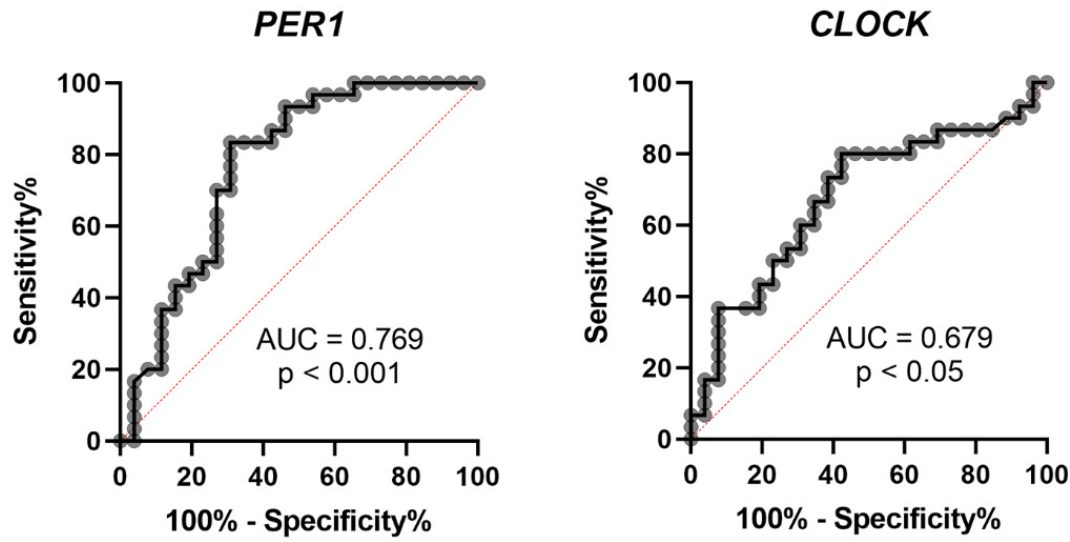
Figure 1. Receiver operating characteristic (ROC) curve of PER1 and CLOCK to predict the diagnosis of MD. AUC: area under the curve.